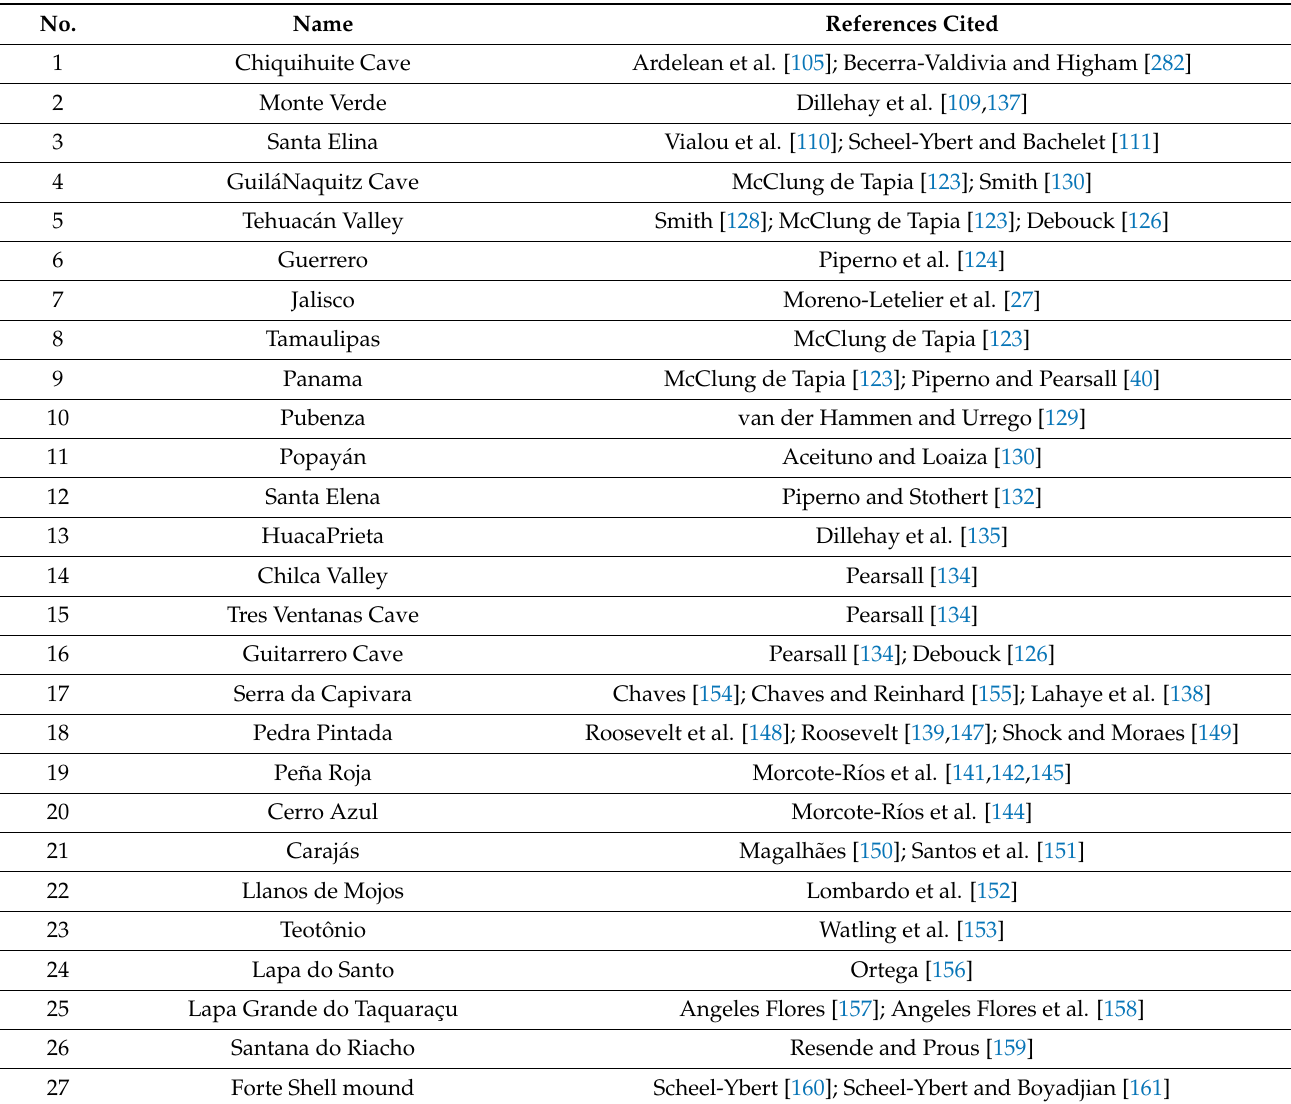
Table A2. Correspondence of archaeological site numbers in Figure 2 with site names and references cited in the text.